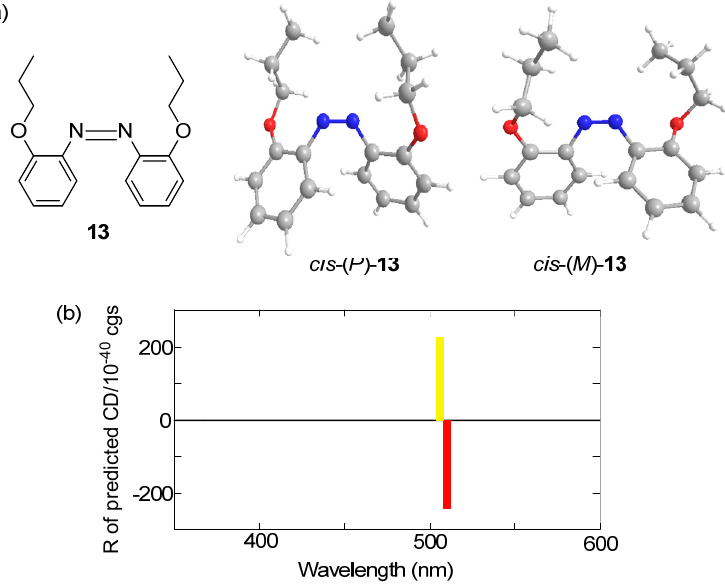
Figure 14. (a) Structures of cis -( P )- 13 and cis -( M )- 13 . (b) CD calculated by the TD-DFT method with the B3LYP/6-31G(d) level of cis -( P )- 13 (red bar), cis -( M )- 13 (yellow bar).